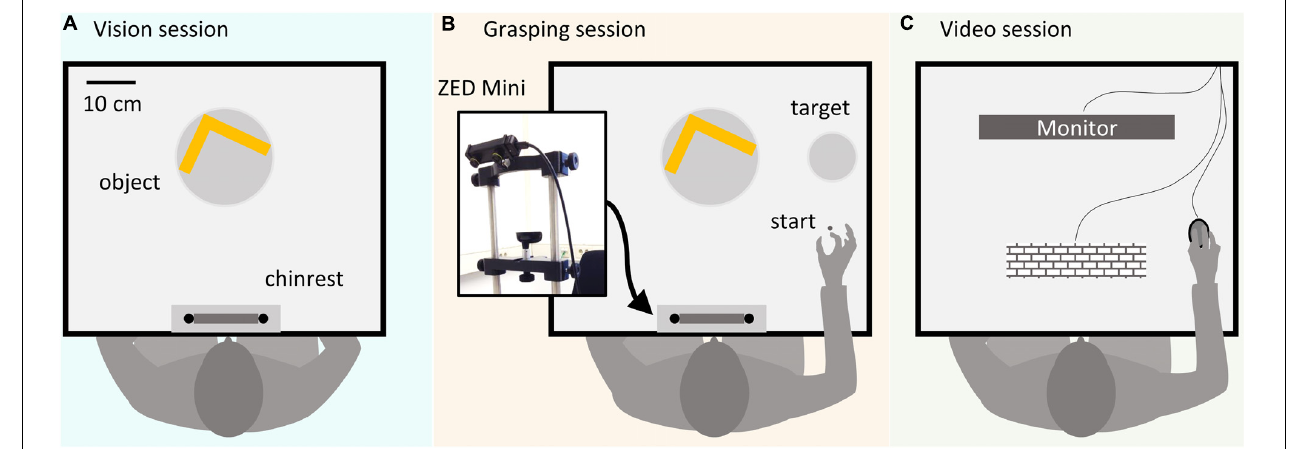
FIGURE 1 | Schematic representation of the experimental setup. (A) In the vision sessions participants passively viewed objects and evaluated the relative optimality of preselected grasps without executing the grasps. (B) In the grasping sessions, participants executed grasps prior to judging the grasp quality. A ZED Mini stereo camera positioned above the participant’s forehead recorded the grasping movements in Experiments 2a and 2b. (C) In the video session, participants from Experiment 2b viewed recordings of grasps executed by participants from Experiment 2a on a computer monitor.